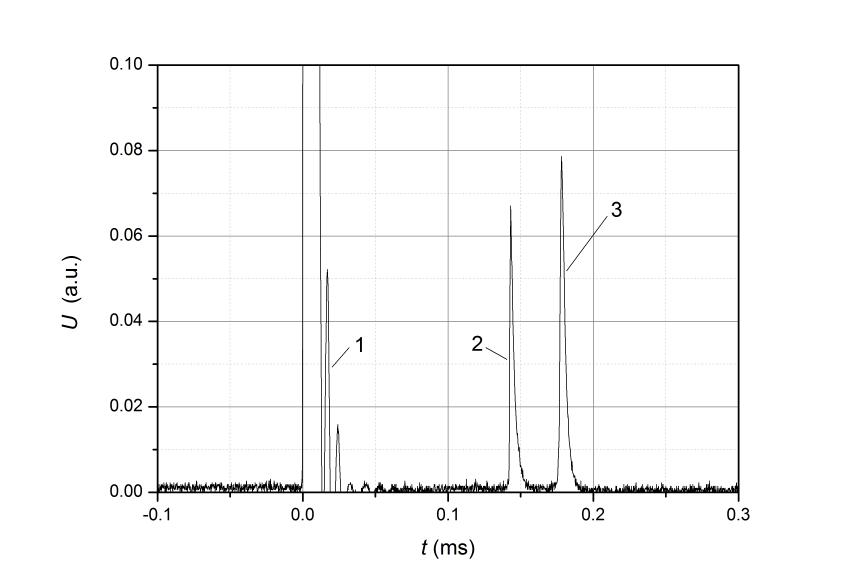
Figure 3. Waveform of the output signal: 1—induced interference caused by the current pulse; 2 and 3—pulses corresponding to the front and decay of the stretching wave.